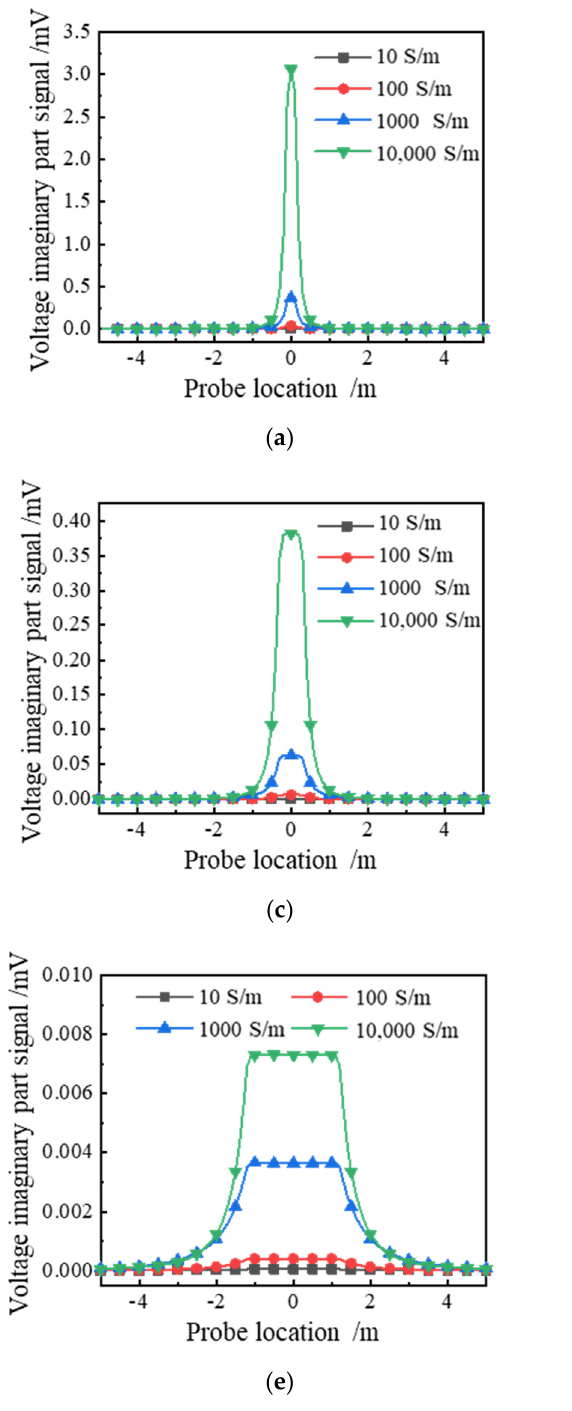
Figure 8. Electromagnetic signal response curves under different fracture conductivities: ( a ) real part signal of subarray 1; ( b ) imaginary part signal of subarray 1; ( c ) real part signal of subarray 4; ( d ) imaginary part signal of subarray 4; ( e ) real part signal of subarray 7; ( f ) imaginary part signal of subarray 7.